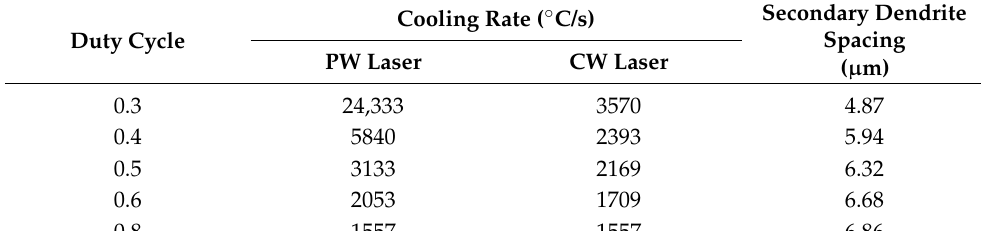
Spacing ( µ m)PW Laser CW Laser